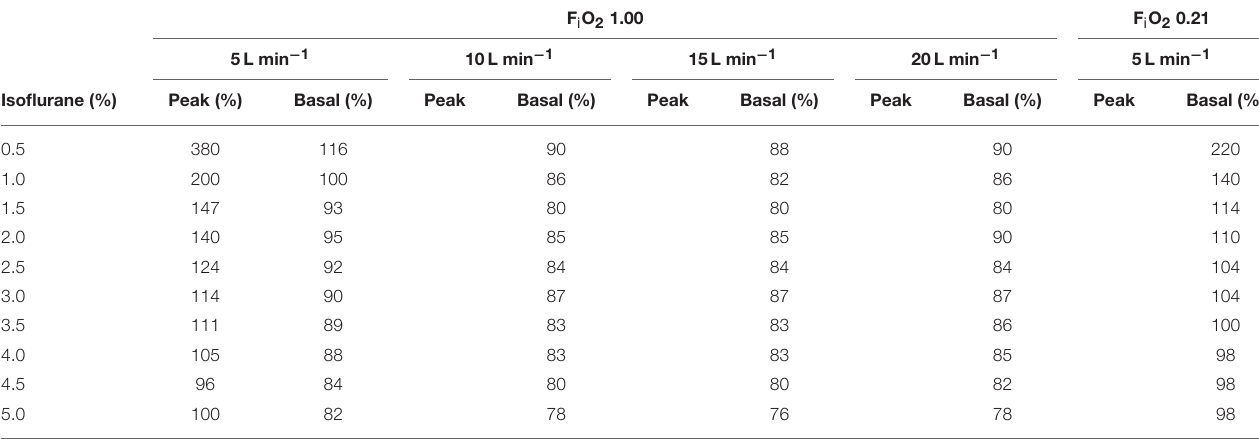
TABLE 2 | Peak and basal isoflurane concentration (in % of the dialed concentration) generated by the intermittent flow of the computer-driven flowmeter at different F i O 2 and across a range of isoflurane dial setting of the vaporizer.